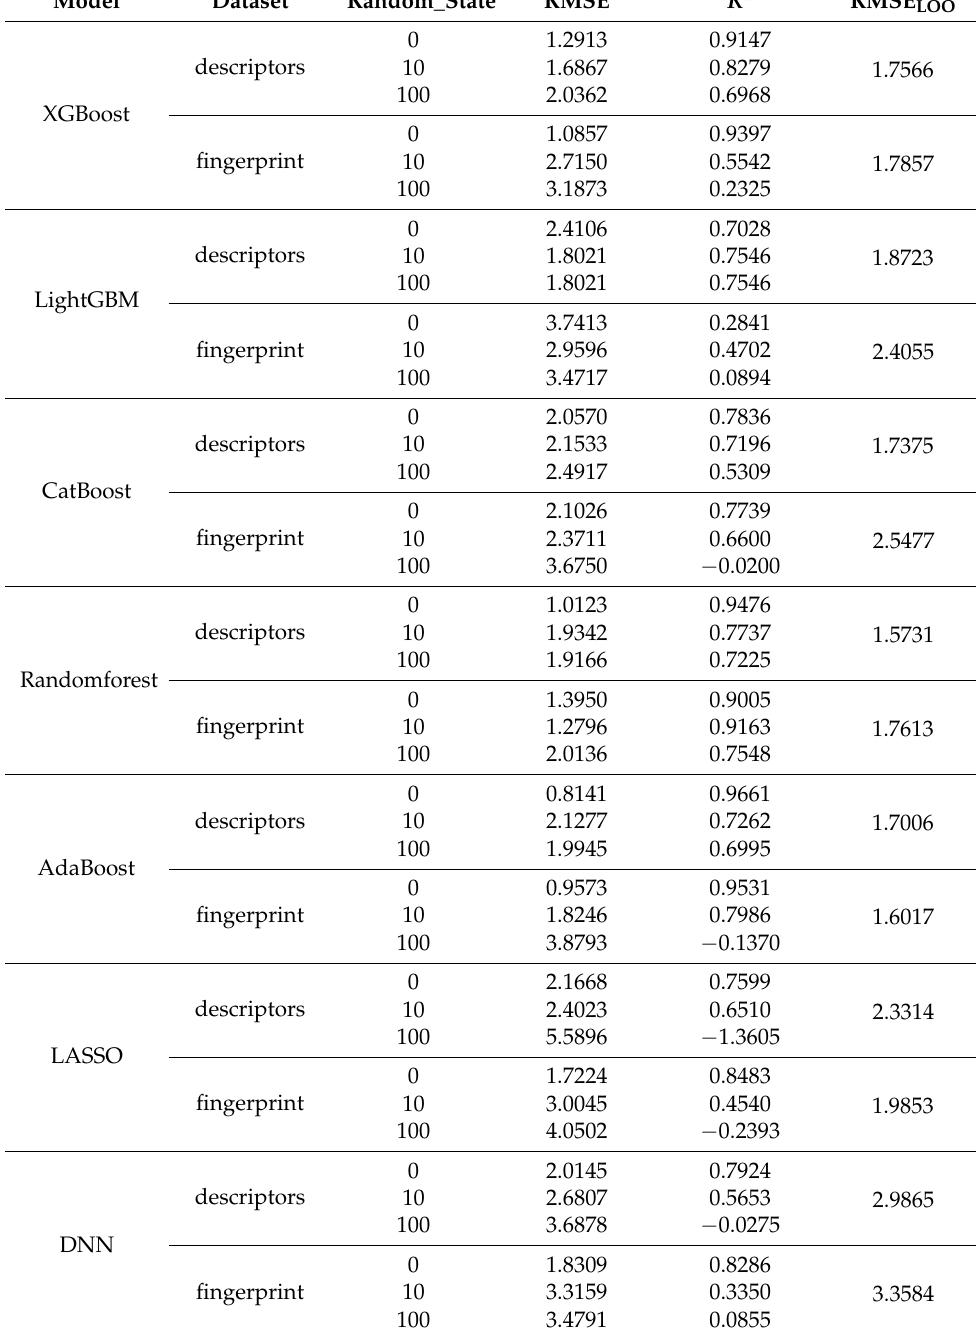
Table 1. Regression metrics values of machine learning using estimator